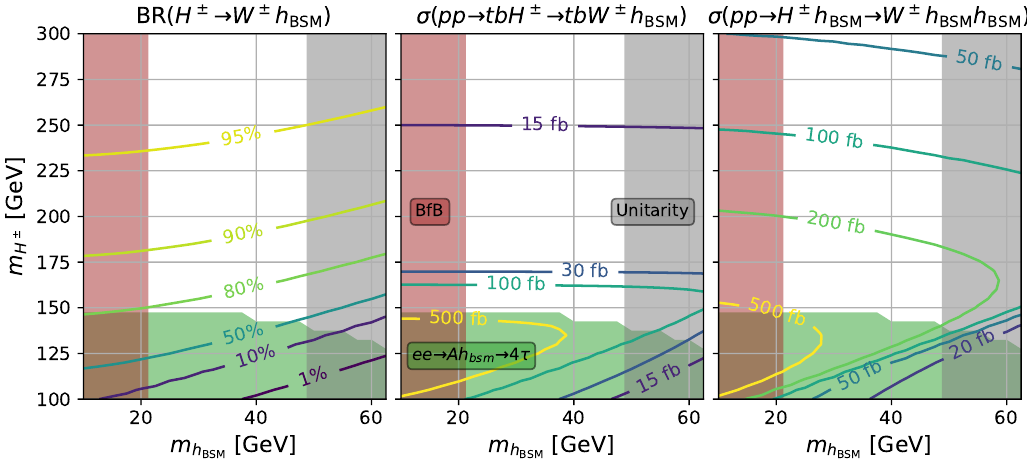
) parameter plane of benchmark sce- Figure 23. Signal cross sections in the ( m , m h H ± BSM nario cH ( Wh ‘ phil ) . All model parameters except for the Yukawa type are identical to the BSM cH ( Wh light ) scenario as given in table 5. The colored contours indicate BR ( H ± → W ± h ) in the BSM BSM left panel and the 13 TeV LHC cross sections for the search processes pp → tbH ± , H ± → W ± h BSM ( center ) and pp → H ± h ( right ). The shaded regions are excluded by per- ± h BSM → W BSM h BSM turbative unitarity, boundedness from below, and LEP searches for di-Higgs production in the 4 τ final state